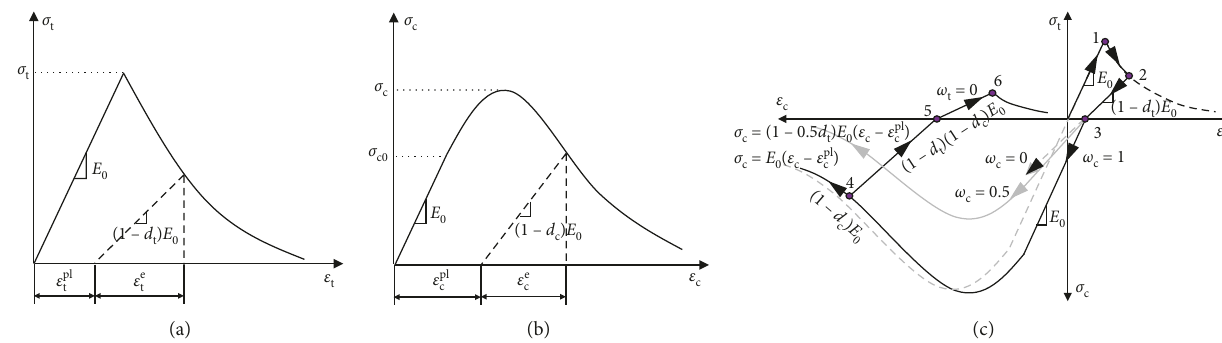
Figure 16: Stress-strain relationships of the CDP model in ABAQUS: (a) compressive curve; (b) tensile curve; (c) uniaxial load cycle (tension-compression-tension) response considering different values for the stiffness recovery